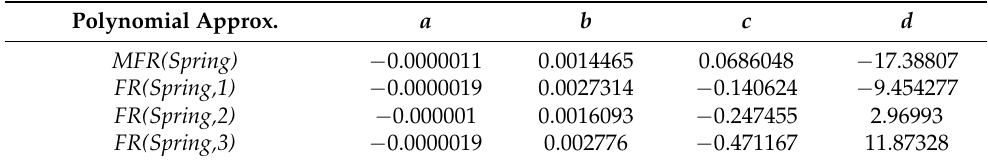
Table 2. An example of the coefficients related to the polynomial approximations of the MFR(Spring) and FR(Spring,i) for 3 traffic flow sensors during the (same) selected period of time in spring. Polynomial Approx. a b c d